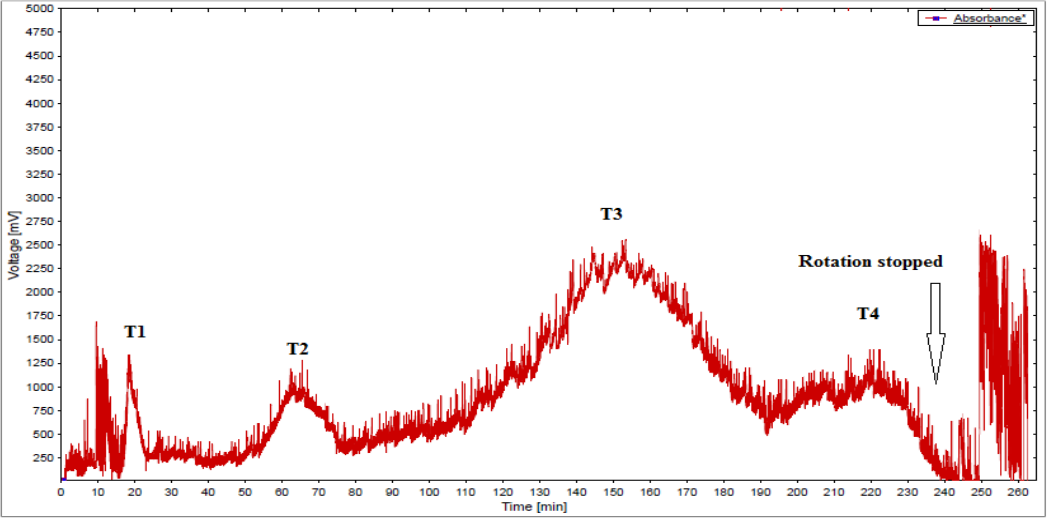
HSCCC conditions: Gradient solvent system: ethyl acetate–n-butanol–water (solvent A: 1:1:1, v/v/v, solvent B: 1:0.5:1, v/v/v, solvent C: 1:0.3:1, v/v/v solvent D: 1:0.2:1, v/v/v); stationary